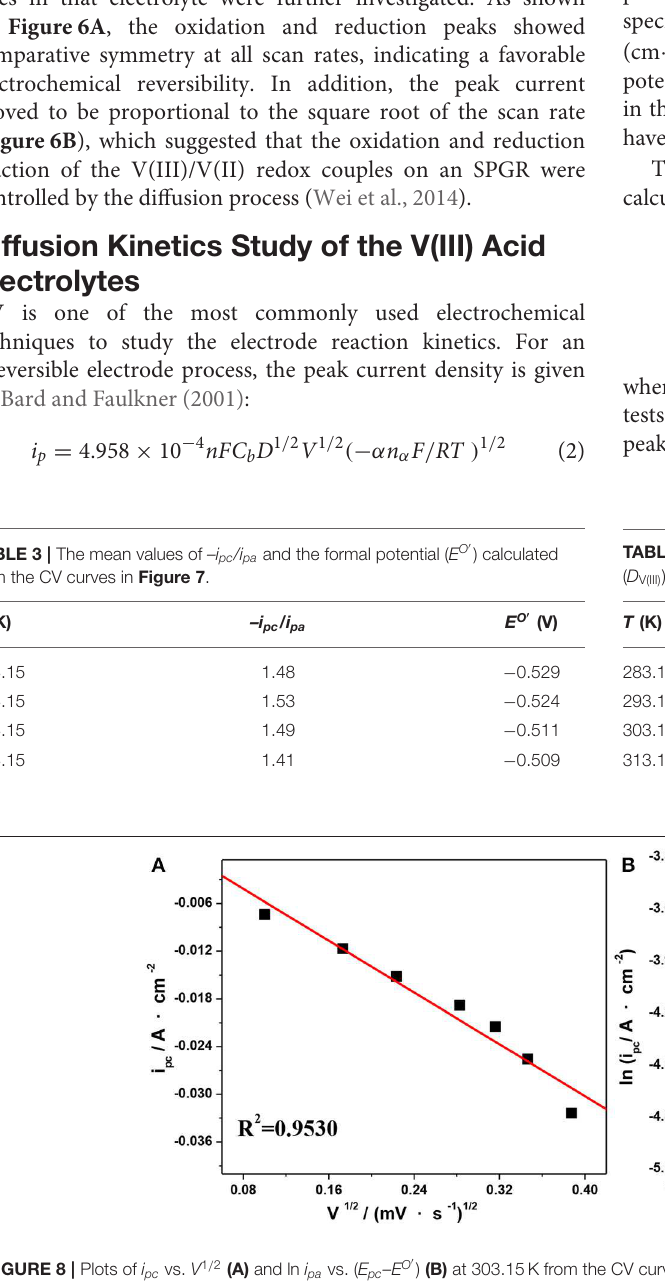
Frontiers in Chemistry |